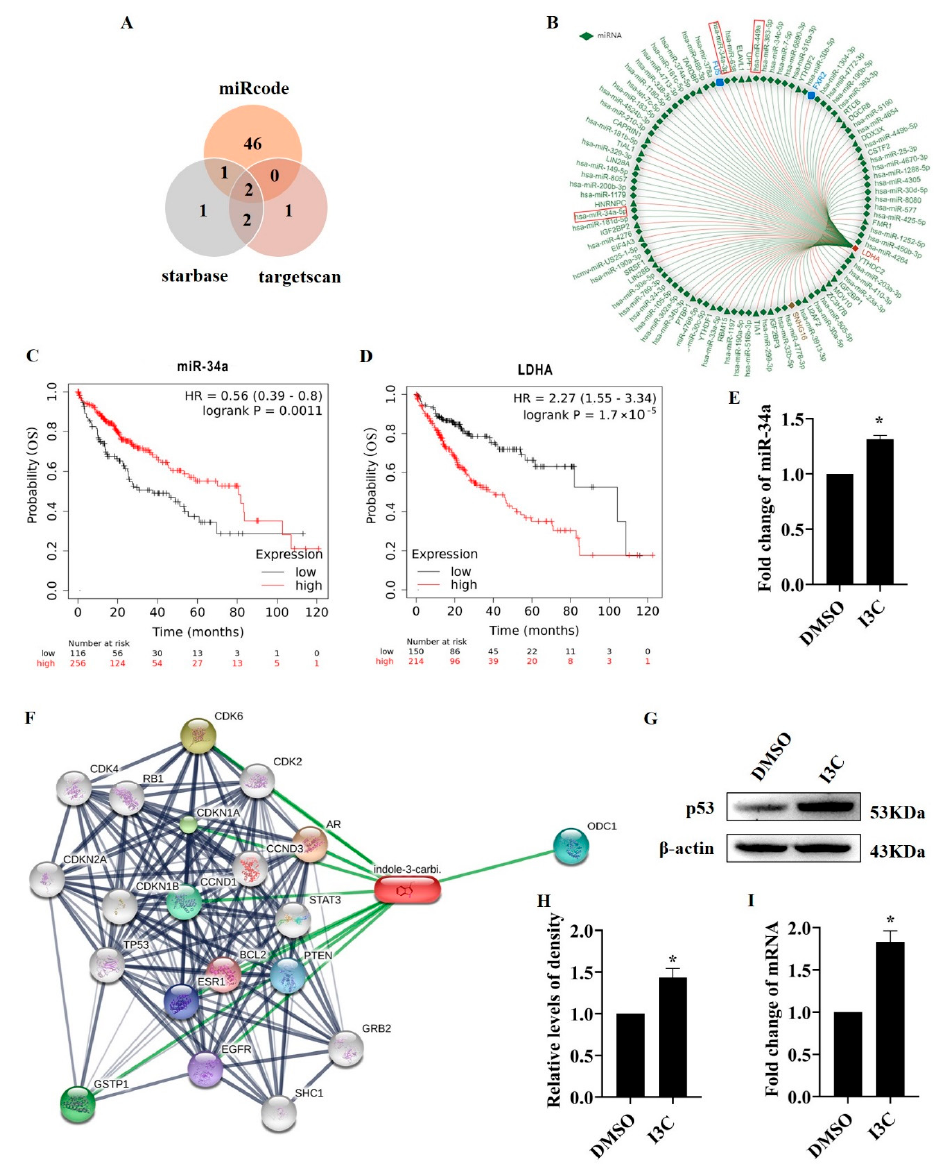
Figure 3. Studies on the molecular mechanism of how I3C treatment inhibited LDHA expression. ( A ) LDHA-targeted miRNAs were predicted using three databases; ( B ) Correlation of miR-34a with LDHA expression in hepatocellular carcinoma tissues. Association between the expression levels of miR-34a ( C ) and LDHA ( D ) and survival in patients with liver cancer; ( E ) The effects of I3C treatment on the expression of miR-34a in HepG2 cells. * p < 0.05 vs. DMSO; ( F ) Prediction of the protein– chemical interaction. ( G ) The effect of I3C treatment on p53 protein expression; ( H ) Densitometric analysis for blots shown in ( G ). * p < 0.05 vs. DMSO; ( I ) Measurement of the mRNA levels of p53 after treatment with DMSO (vehicle) and I3C. * p < 0.05 vs.